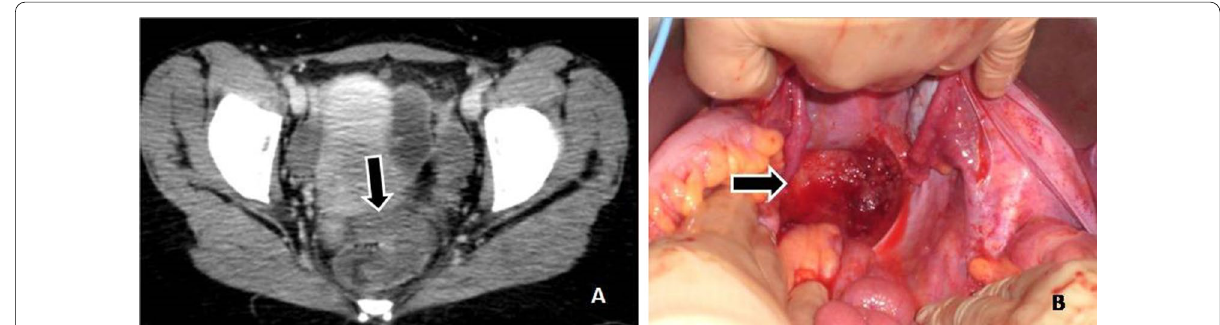
Fig. 4 a An enhancing mass is demonstrated in the pouch of Douglas (arrow). b The lesion as seen at surgery (arrow)